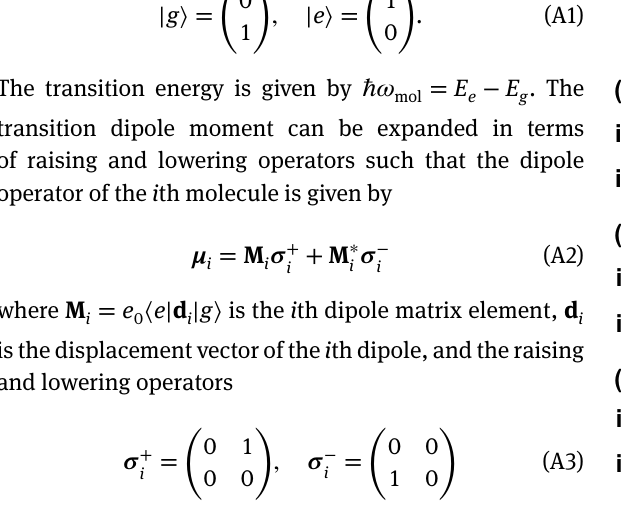
Figure 6: Varying molecular positions at partial filling: Schematic showing molecular distributions centred (in the first grating period) about (a) C = mod[ x , Λ ] = 0 with spread (i) S = 0 and (ii) S = Λ∕ 2, (b) C = Λ∕ 4 with spread (i) S = 0 and (ii) S = Λ∕ 2, and (c) C = Λ∕ 2 with spread (i) S = 0 and (ii) S = Λ∕ 2. The dispersion relations for these systems are plotted in Figure 7. The dispersion relations for the systems in which the molecular distributions are centred about (a) x = 0 and (c) x = Λ∕ 2 are unsurprisingly the same, and possess the same symmetry with respect to the grating. When the molecules are instead centred around (b) x = Lambda ∕ 4, the dispersion relation is not the same as for C = 0 and C = Λ∕ 2. However, S = 0 still gives a dispersion relation with four bands, and when S > 0 we see five bands. The non-zero spread of the molecules is thus the parameter driving the change in band number, rather than e.g. breaking of mirror symmetry. The change in the dispersion relation for C = 0 versus C = Λ∕ 4 is due to the individual molecules seeing a different local electric field when they are placed at different positions in relation to the grating, and so the collective coupling strength of all the molecules will be different, reflected in the magnitude of the band splitting as seen in Figure